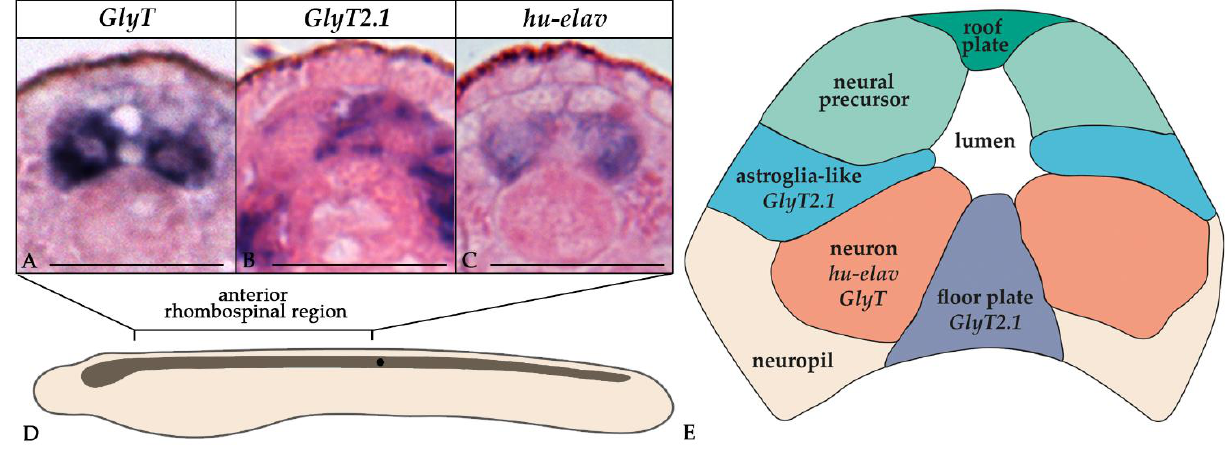
Figure 7. Differential expression of GlyT and GlyT2.1 in neurons and glia in developing amphioxus. ( A – C ) Cross-sections of the anterior rhombospinal region of the nerve cord of a T1-stage embryo stained for GlyT, GlyT2.1 , and hu-elav . ( D ) Diagram of a T1-stage embryo with the nerve cord highlighted. The black dot marks the position of the first pigment spot in the nerve cord. ( E ) Diagrammatic representation of a typical cross-section of the rhombospinal region of the nerve cord of a T1-stage amphioxus embryo (adapted from [37]). Neurons, identified by the expression of hu-elav , are mostly limited to ventrolateral positions, whereas mediolateral cells and ventral cells are glial cells. Scale bars are 25 µm.